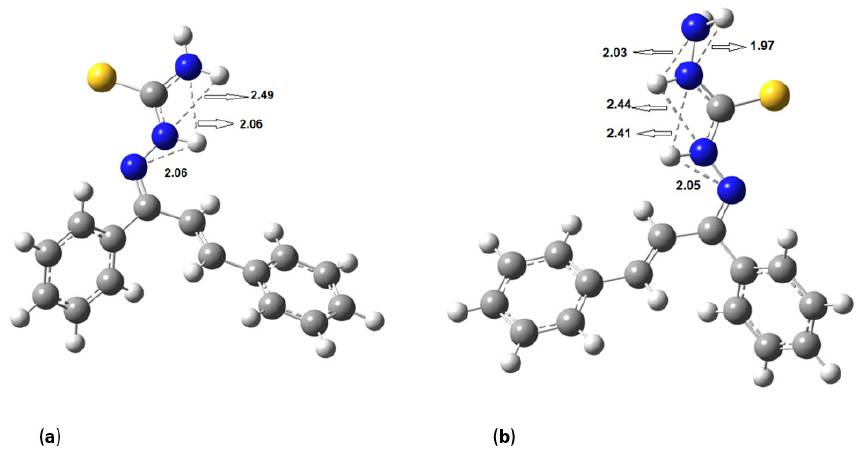
Figure 5. Conformations with hydrogen bonds for ( a ) KKI15 and ( b ) KKI18.